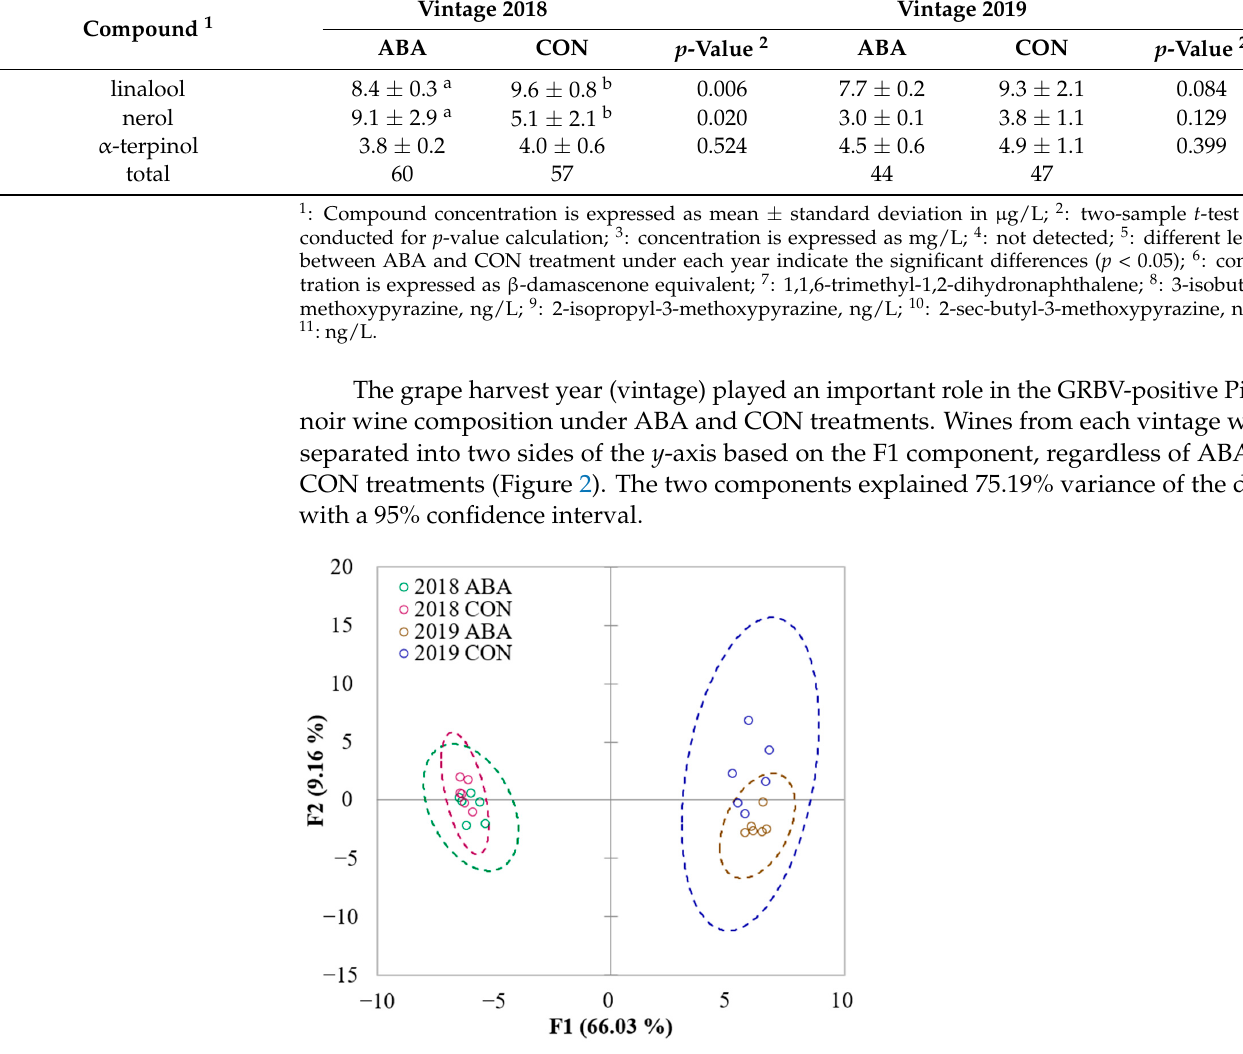
Figure 2. Score plot of principal component analysis on wines from GRBV-positive Pinot noir under exogenous abscisic acid (ABA) application and no abscisic acid control (CON) across two seasons ( n = 6) in Oregon’s Willamette Valley. The plot was generated using the wine volatile profiles. Dash circles represent 95% confidence interval.